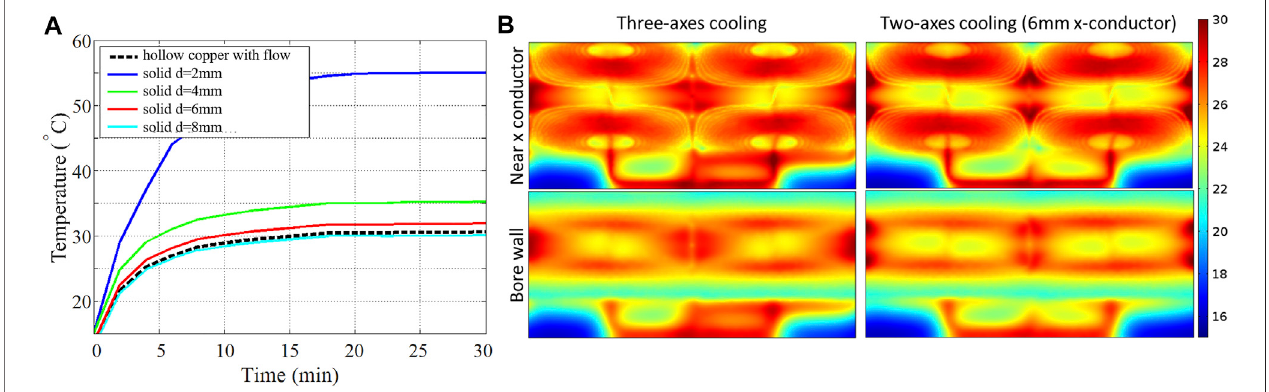
FIGURE 10 | Ef fi cient gradient cooling. (A) Temperature as a function of time. (B) Temperature distribution on the inner bore.